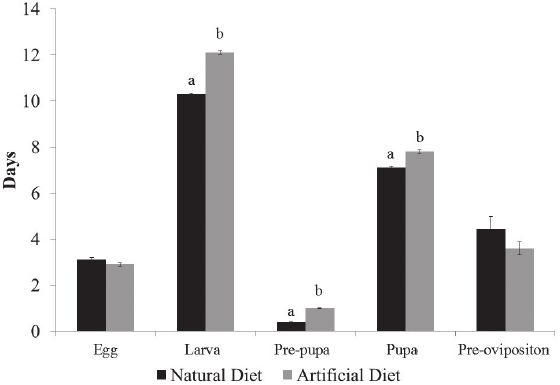
Figure 4 - Duration of the development stages (egg, larva, pre-pupa, pupa, N=30) and pre-oviposition of Condylorrhiza vestigialis on natural (poplar leaves) and artificial (corn, wheat germ and yeast-based) diets; temperature 25 ± 2 °C, RH 60 ± 10% and photophase of 14 h. Means followed by the same letter do not differ by the log-rank test ( P >